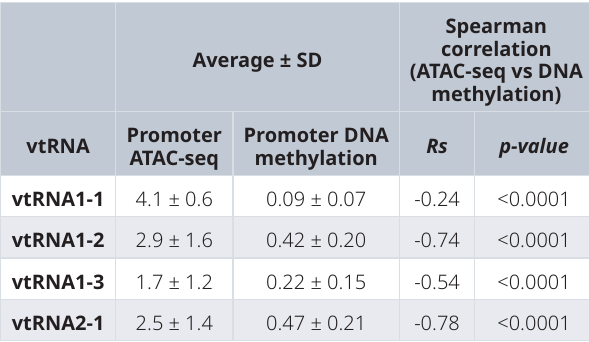
Table 1. Correlation between vtRNA promoters ATAC-seq and DNA methylation values in the Pan-Cancer TCGA samples.